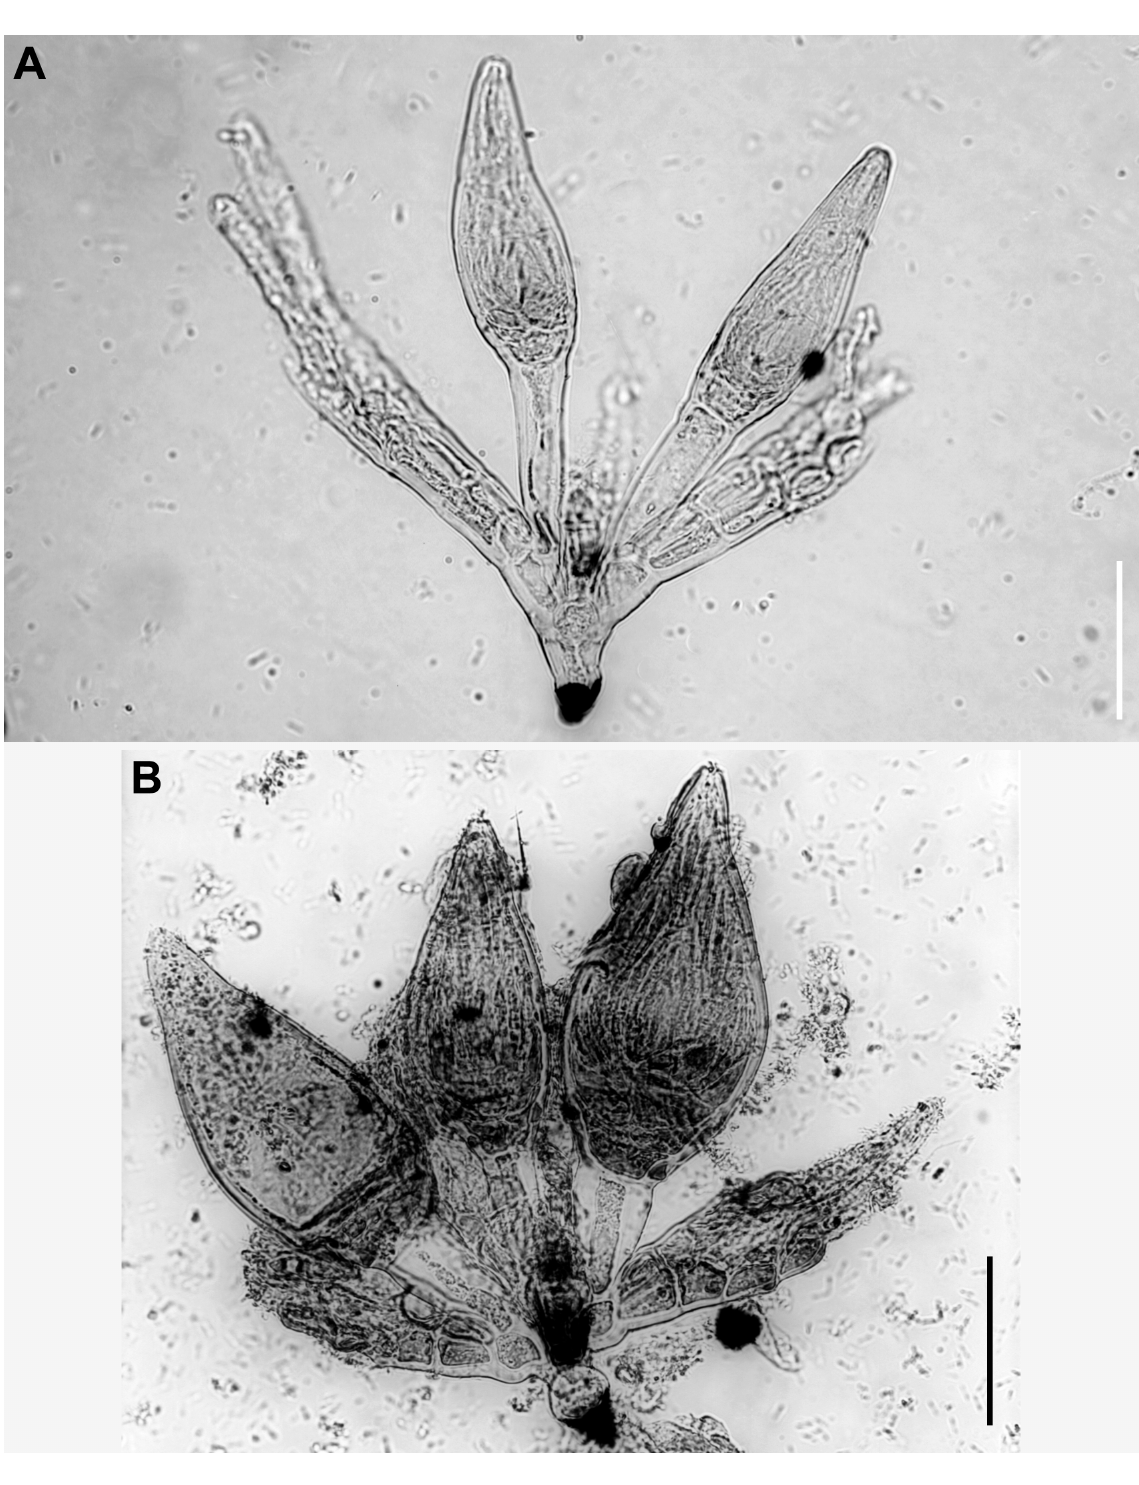
Fig. 83. Monoicomyces spp. Old photographs taken from FH type slides. A . M. britannicus Thaxt . (slide FH2353). B . M. homalotae Thaxt. (slide FH2402). Scale bars: 50